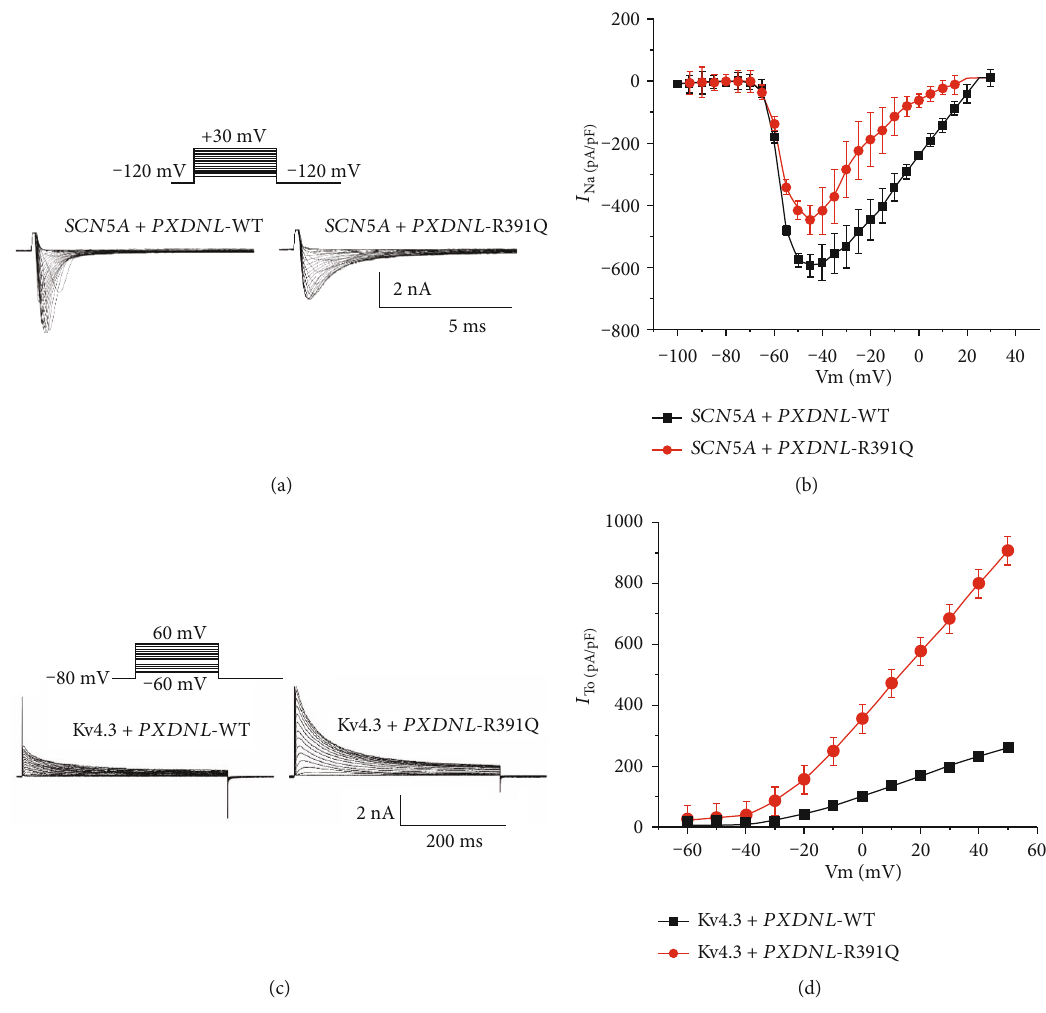
Figure 8: (a) Representative I recordings from a WT and R391Q mutant in PXDNL cotransfected with SCN5A. I – V relation for WT and Na R391Q mutant in PXDNL cotransfected with SCN5A. The I-V relation was generated using same voltage clamp protocol described in Figure 5. A small reduction in I density was noted with R391Q mutation. Representative I Na mutant in PXDNL cotransfected with KCND3. Current recordings were obtained at test potentials between − 60 and 50 mV from a holding potential was − 80mV. (c) I – V relation for WT and R391Q showing a signi fi cant di ff erence in I -20